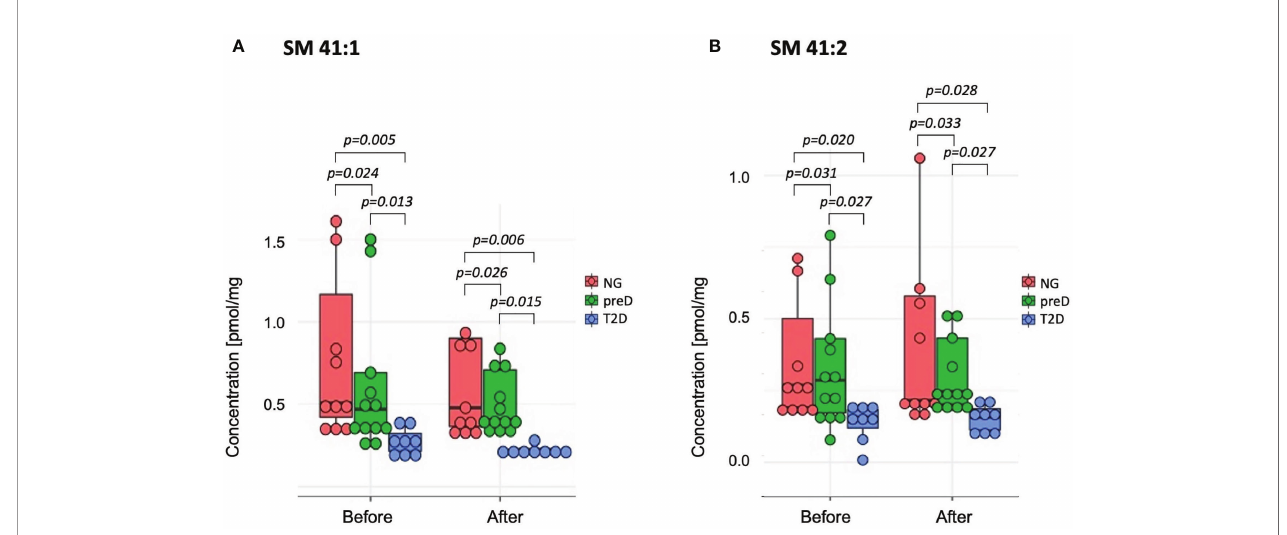
FIGURE 3 | Sphingomyelins with signi fi cant differences among diagnosis groups – normoglycemia (NG), prediabetes (preD) and type 2 diabetes (T2D), before and after 3 months of exercise intervention. (A) SM 41:1; (B) SM 41:2. Mean and standard errors are presented.